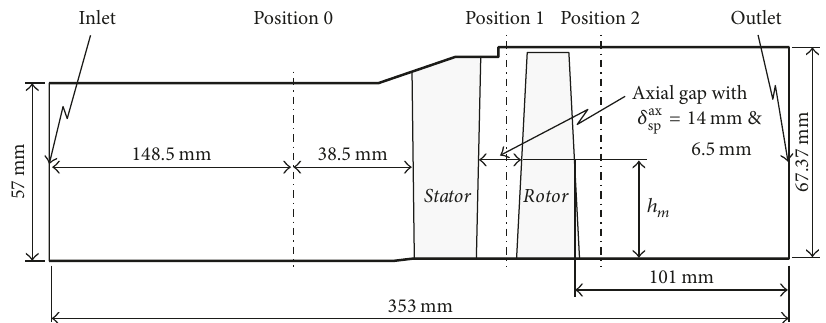
Figure 2: Meridional plane of the experimental and computational domain for the applied axial turbine.